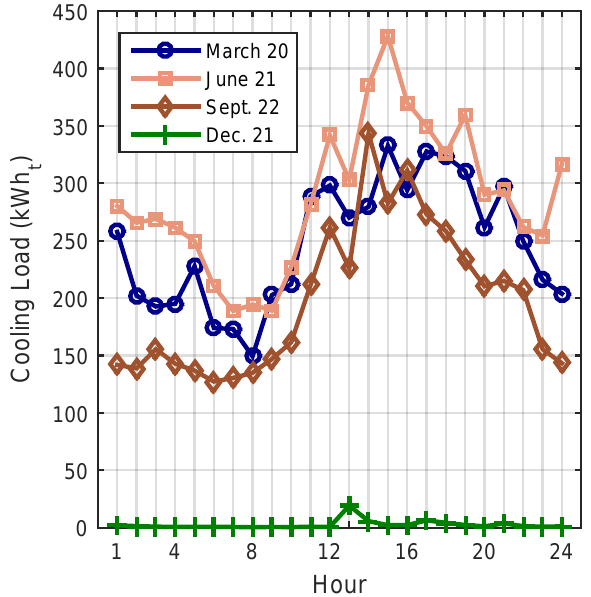
Figure 4. Average cooling load of the districts of